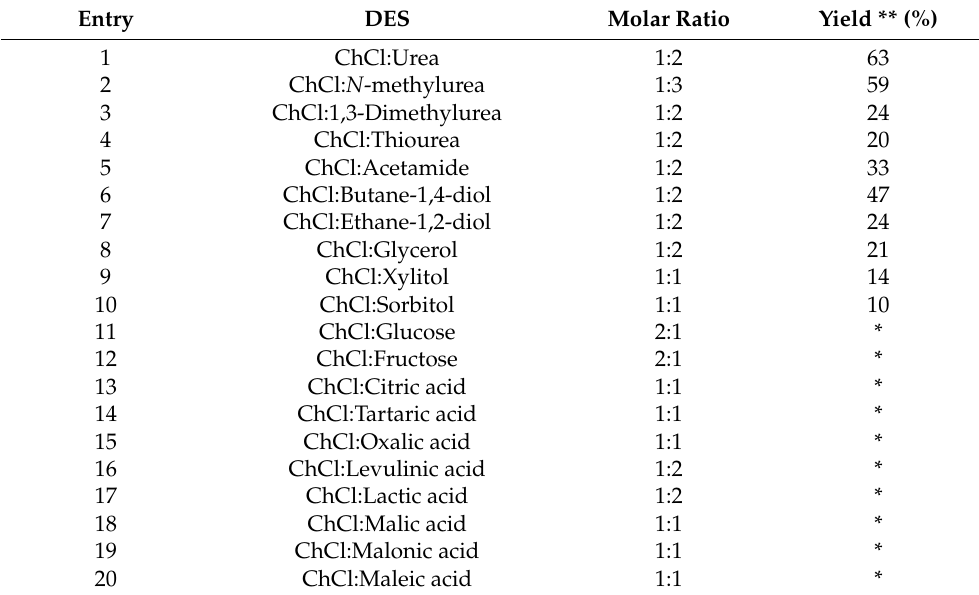
Table 1. 2-Mercapto-3-phenylquinazolin-4(3 H )-one yields obtained in different choline chloride- based DESs at 80 ◦